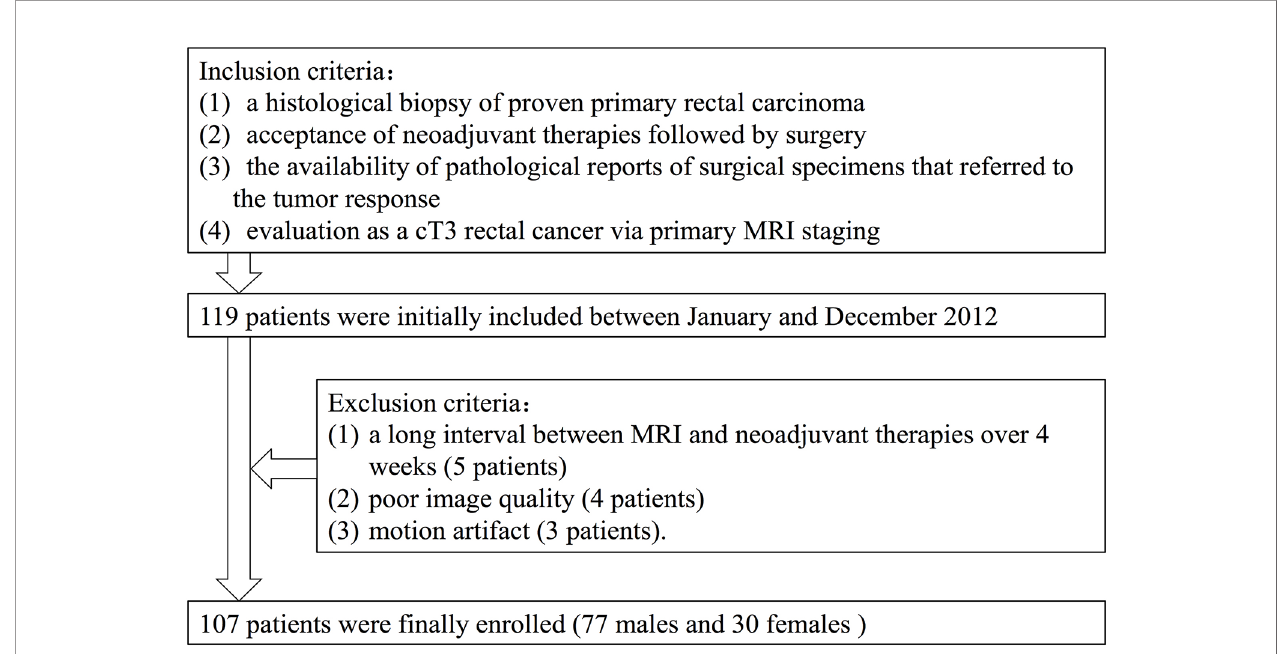
FIGURE 1 | Flowchart of the study